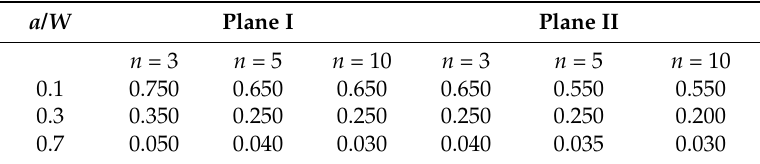
Table 5. Maximum predicting loads ( σ / σ 0 ) for 3D SECP under uniaxial loading ( λ = 0.0), in plane I and II. a/W Plane I Plane